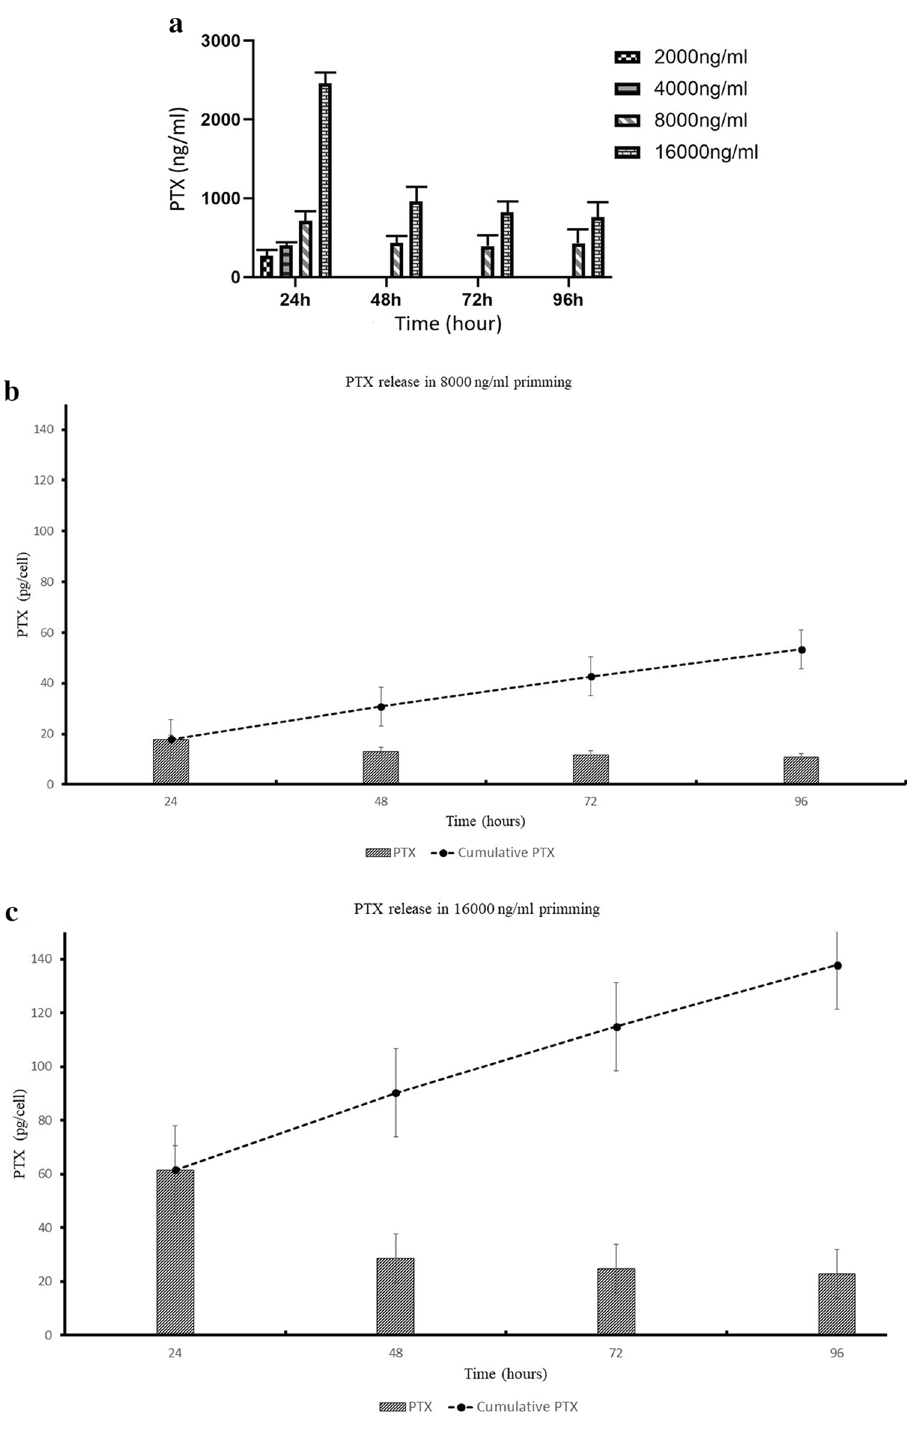
Figure 8. PTX release by hAECs. ( a ) Evaluating the amounts of PTX in CM of PTX-loaded hAECs showed that these cells released PTX in their CM for up to 96 h. Although hAECs released PTX during the first 24 h in all treated concentrations, only 8000 and 16,000 ng/ml-treated hAECs released PTX up to 96 h. ( b , c ) Evaluating the release pattern of hAECs loaded with PTX at 8000 ng/ml ( a ) and 16,000 ng/ml ( b ), hAECs released PTX for 96 h in a steady pattern which was more prominent in the first 24 h. The dotted line shows cumulative amounts of released PTX from 24 to 96 h, showing a steady and sustained release pattern for